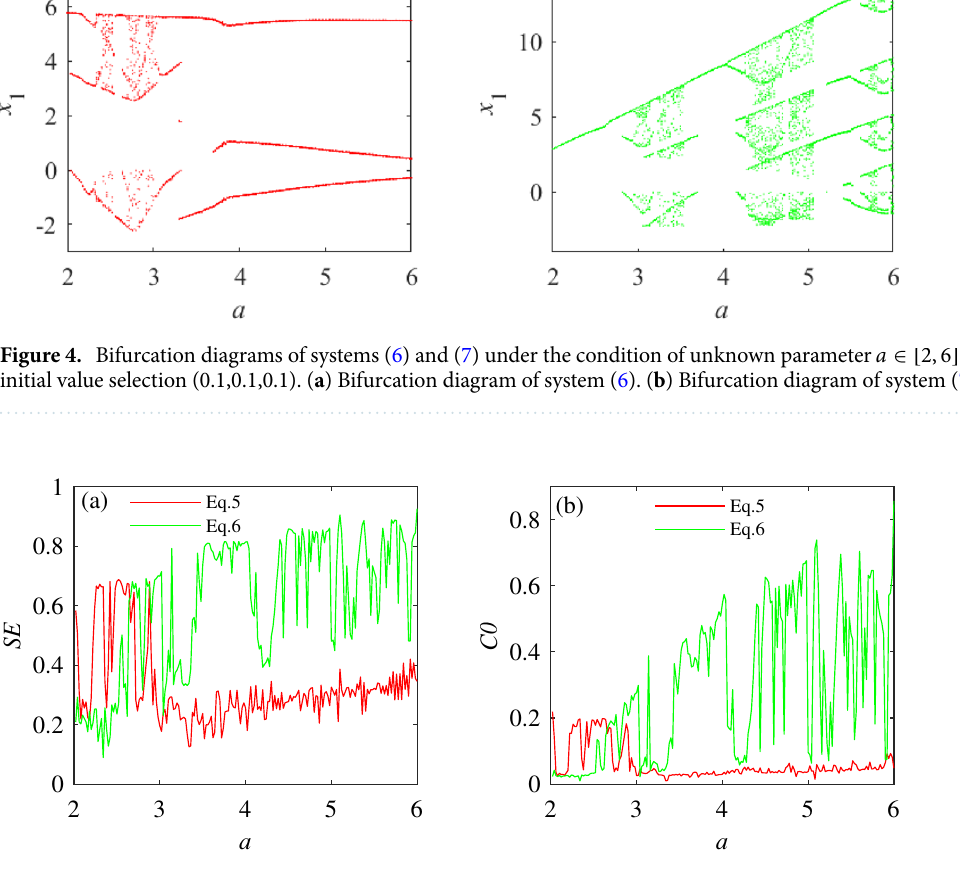
Figure 5. SE complexity and C0 complexity obtained by systems (6) and (7) under the conditions of unknown 2, 6 parameter a and initial value selection (0.1,0.1,0.1). ( a ) SE complexity. ( b ) C0 ∈ [ ]